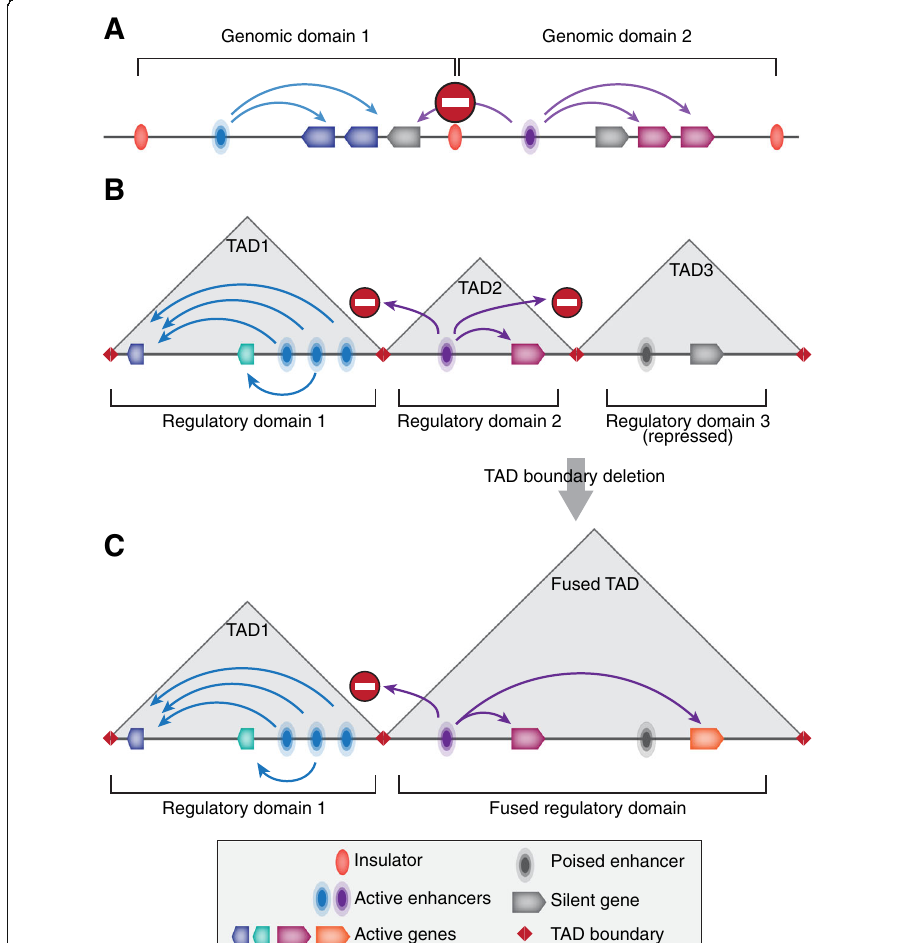
Fig. 2 Chromosome partitioning into TADs reflects genome partitioning into regulatory domains delimiting zones of enhancer influence. Conventional concept of genomic domain implies that the entire genome is partitioned into non-overlapping parts (domains) containing gene clusters and regulatory regions ( a ), and demarcated with insulators preventing cross-talk between regulatory systems of the adjacent domains. According to current views, zones of enhancer influence (regulatory domains) largely overlap with TADs ( b ) that spatially confine communication between genes and enhancers located within adjacent regulatory domains. Deletion of TAD boundary leads to TAD fusion and, consequently, to fusion of corresponding regulatory domains resulting in abnormal enhancer-promoter communication and transcription dysregulation ( c